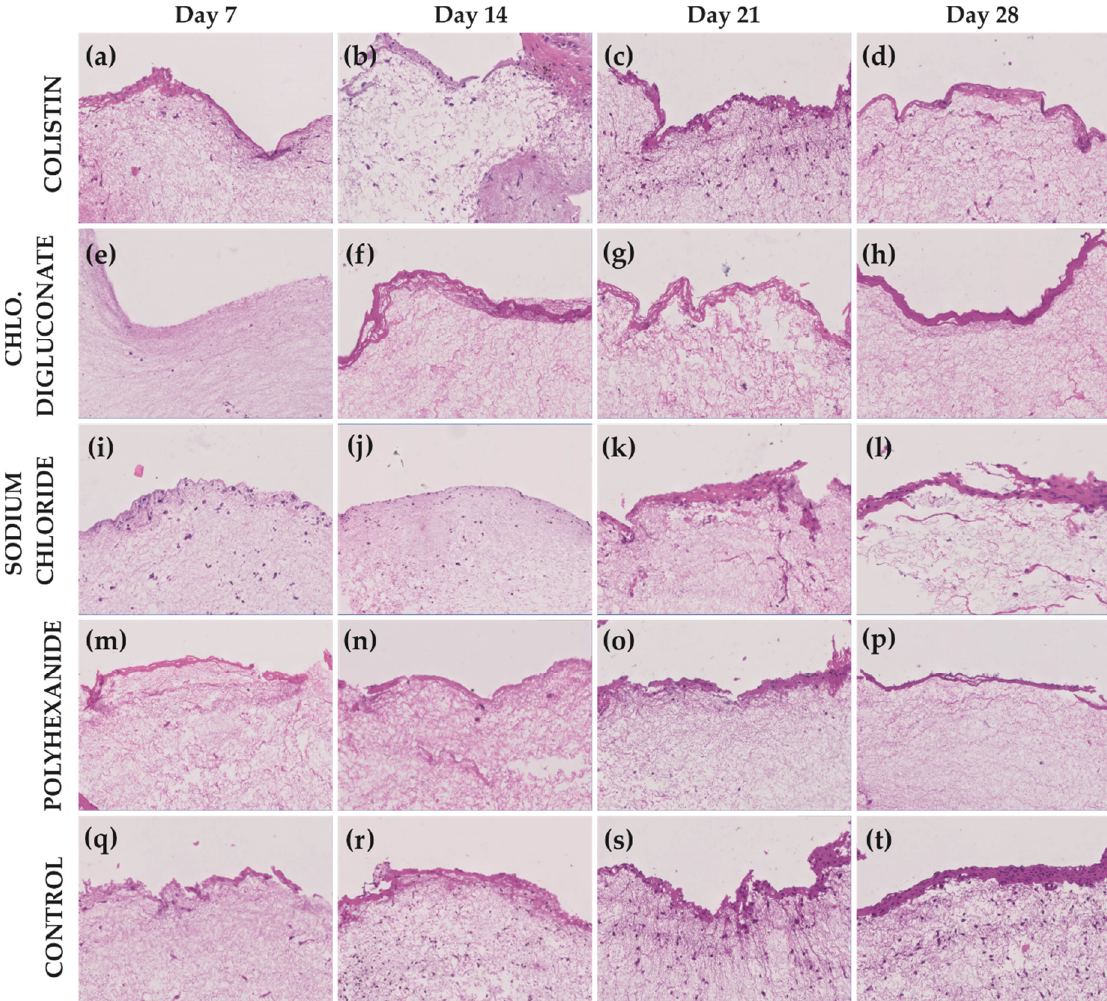
Figure 8. Hematoxylin and eosin staining of BASS after each treatment and control at days 7, 14, 21, and 28. ( a – d ) BASS after colistin (1%) treatment at day 7, 14, 21, and 28, respectively; ( e – h ) BASS after chlorhexidine digluconate (1%) treatment at day 7, 14, 21, and 28, respectively; ( i – l ) BASS after sodium chloride (0.02%) treatment at day 7, 14, 21, and 28, respectively; ( m–p ) BASS after Polyhexanide (0.01%) treatment at days 7, 14, 21, and 28, respectively; ( q – t ) Control at days 7, 14, 21 and 28 respectively. n = 3. Magnification 10 × .